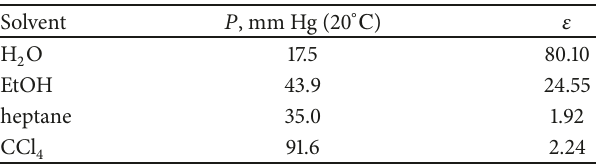
Table 2: Saturated vapor pressure P and dielectric constant 𝜀 of